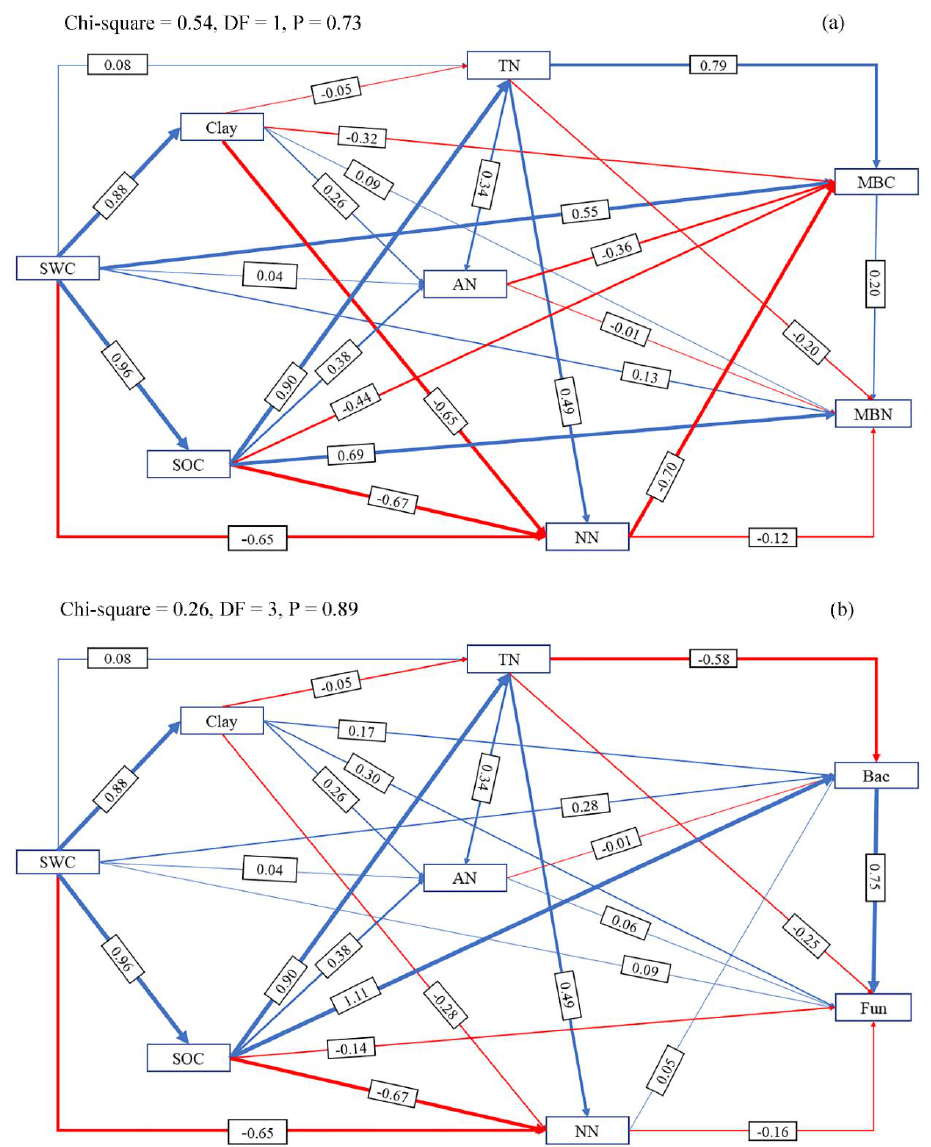
Figure 7. Direct and indirect effects of soil water content (SWC) on microbial biomass carbon (MBC) and microbial biomass nitrogen (MBN) by influencing soil physical and chemical properties were shown in ( a ). And the direct and indirect effects of soil water content (SWC) on bacteria abundance and fungi abundance by influencing soil physical and chemical properties were shown in ( b ). Blue lines indicate positive direct effects and red lines indicate negative direct effects. SWC, soil water content; Clay, soil clay content; SOC, soil organic carbon; TN, soil total nitrogen content; NN, soil nitrate nitrogen; AN, soil ammonium nitrogen content; MBC, microbial biomass carbon; MBN, microbial biomass nitrogen; Bac, bacteria abundance; Fun, fungi abundance.